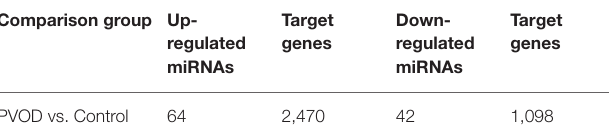
TABLE 1 | Prediction of number of differential expression miRNAs and their target